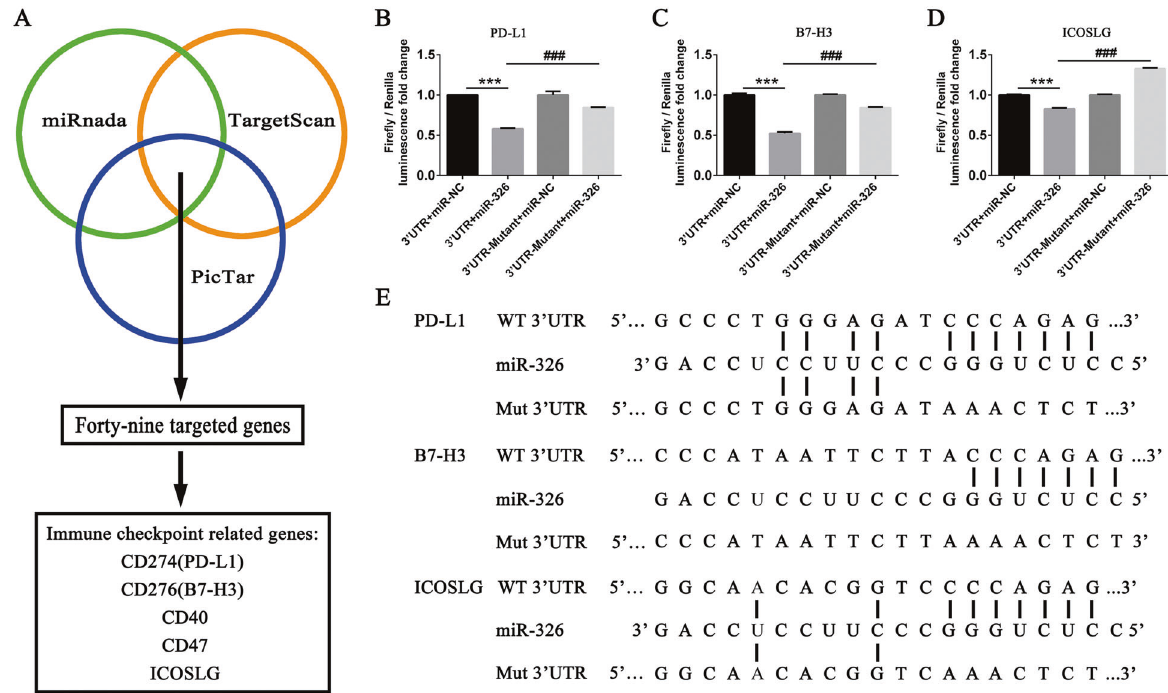
Fig. 1 PD-L1, ICOSLG, and B7-H3 are the direct target genes of miR-326. A Software (miRBase, PicTar, and TargetScan) prediction of the miR- 326-targeted genes. B – D 293T cells were transfected with luciferase reporter plasmid containing PD-L1/B7-H3/ICOSLG wild-type or mutant- type 3 ′ UTR and miR-NC ( n = 3). E Schematic diagram of the binding sites between miR-326 and the target genes (PD-L1, B7-H3, and ICOSLG) and their mutant sequence. All data were presented as mean ± SEM. Comparisons between groups for statistical signi fi cance were performed with two-way ANOVA with Tukey ’ s post hoc test ( B – D ). *** P < 0.001 versus 3 ′ UTR + miR-NC. ### P < 0.001 versus 3 ′ UTR +